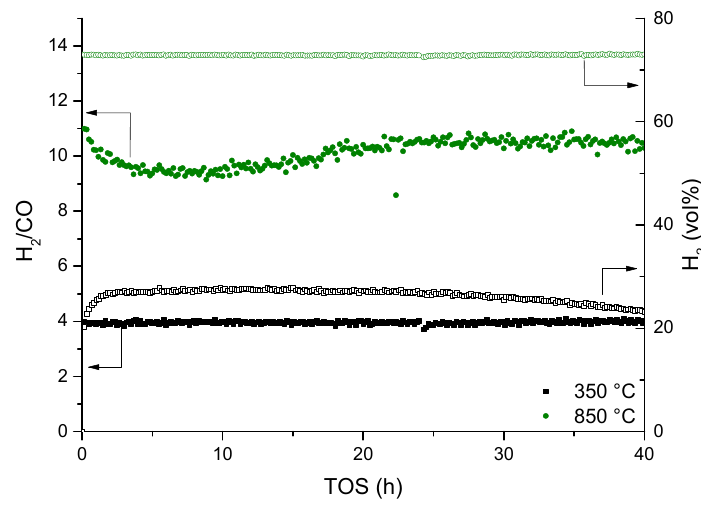
Figure 5. Steam reforming of permeate natural gas over Rh1/Al 2 O 3 at S/C ratio of 4 and temperatures of 350 and 850 °C.